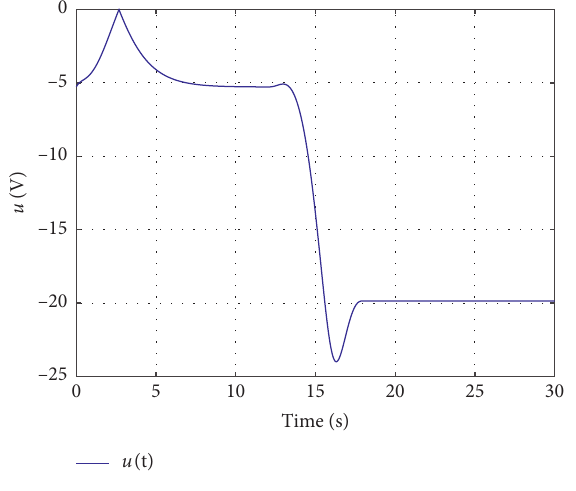
Figure 4: Control input.